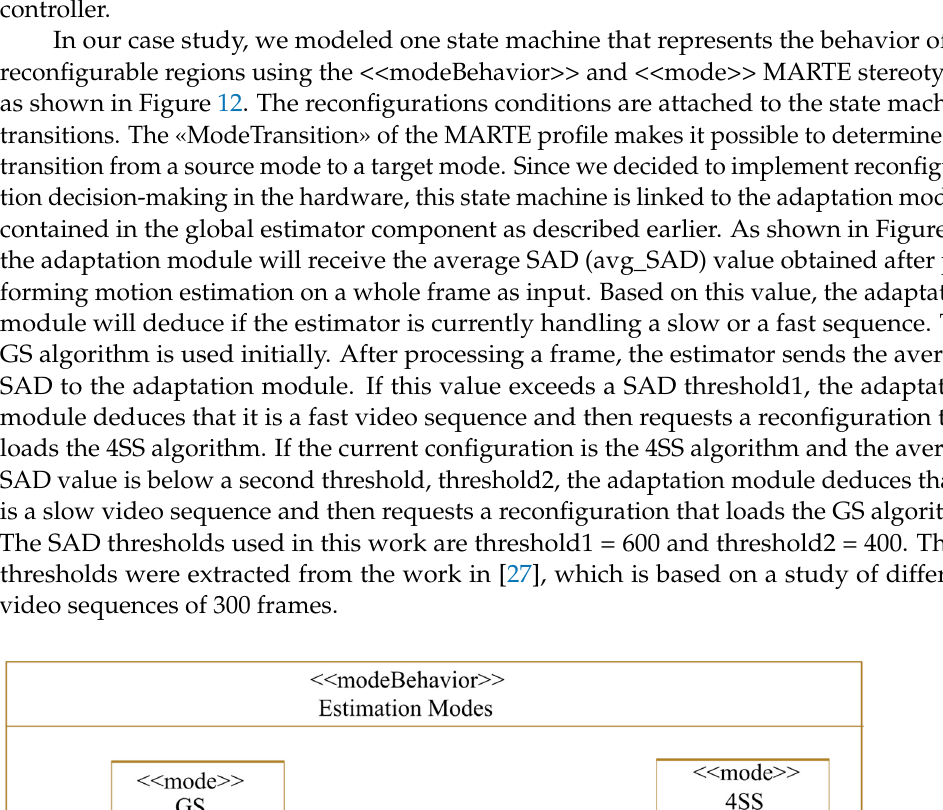
Figure 13. Allocation of the reconfigurable estimator task (the GS mode).